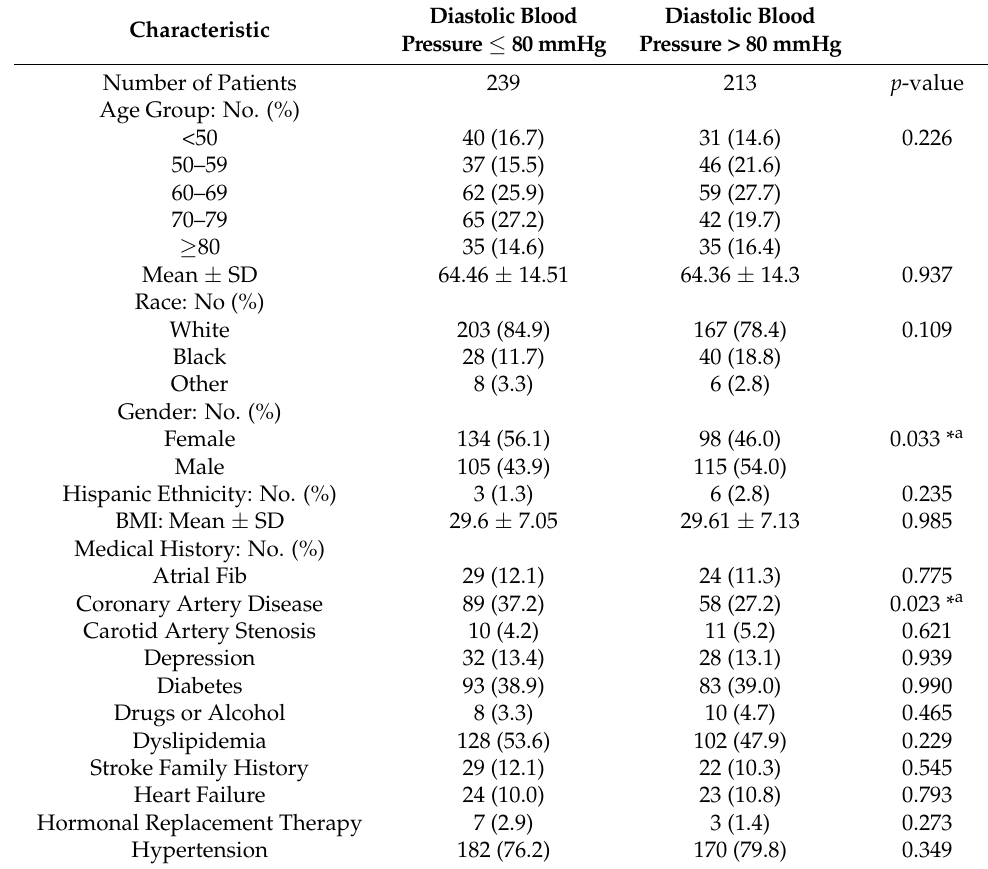
Table 1. Demographic and clinical characteristics of ischemic stroke patients divided by diastolic blood pressure ≤ 80 mmHg or >80 mmHg. Results for continuous variables are presented as mean ± SD, while discrete data are presented as percentage frequency. Pearson’s Chi-squared was used to compare demographic and clinical characteristics differences in patients with a diastolic blood pressure ≤ 80 mmHg or > 80